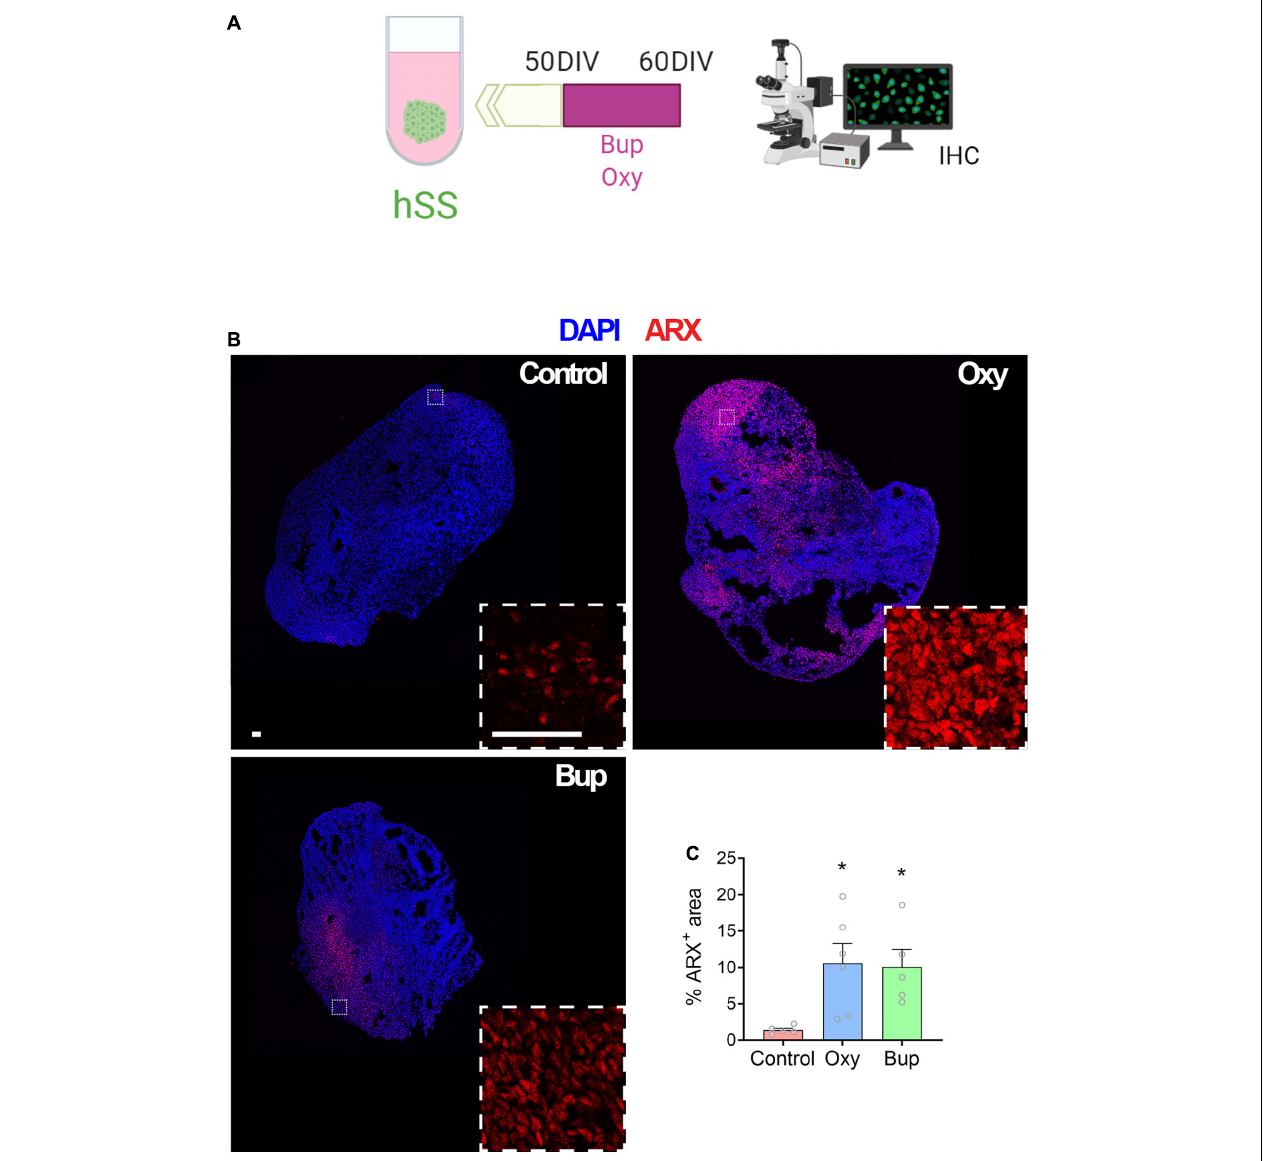
FIGURE 2 | Buprenorphine alters markers of interneuron development in subpallial spheroids. The experimental design is depicted in (A). Representative images of ARX immunolabeling (B) . Both oxycodone and buprenorphine treatment increase ARX area in subpallial spheroids (C) . n = 5-6 organoids. Scale bar = 50 µ m. * p < 0.05. DIV,days in vitro ;